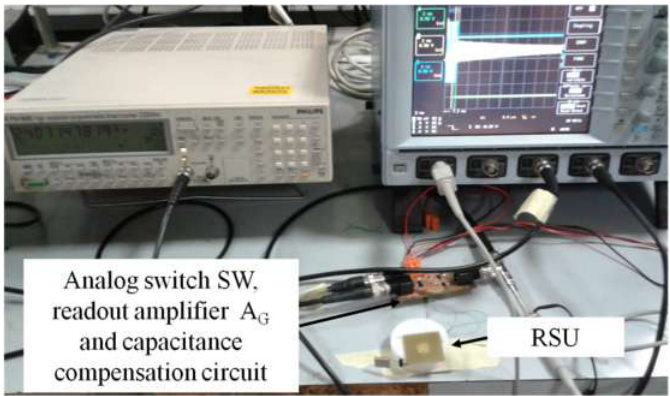
Figure 21. Picture of the experimental setup developed to implement the time-gated technique. Under ideal complete compensation, the measured f dP approaches the unaffected value of f d discussed in Section 3.2. Then, for the considered RSU with Q s = 91, a relative deviation | f dP − f S |/ f S as low as 15 ppm is obtained from Equation (8).